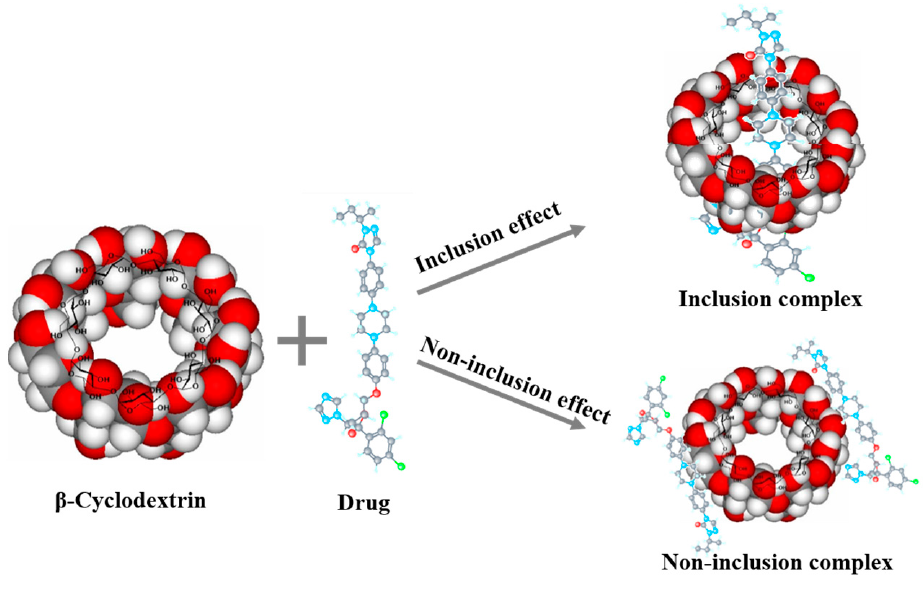
Figure 3. Illustration of inclusion complexes and non-inclusion of cyclodextrins.